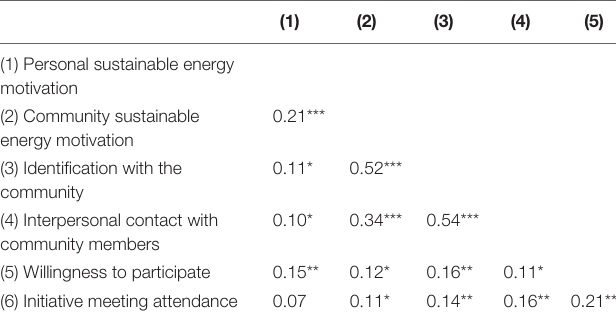
TABLE 1 | Correlations between all dependent and independent variables used in the